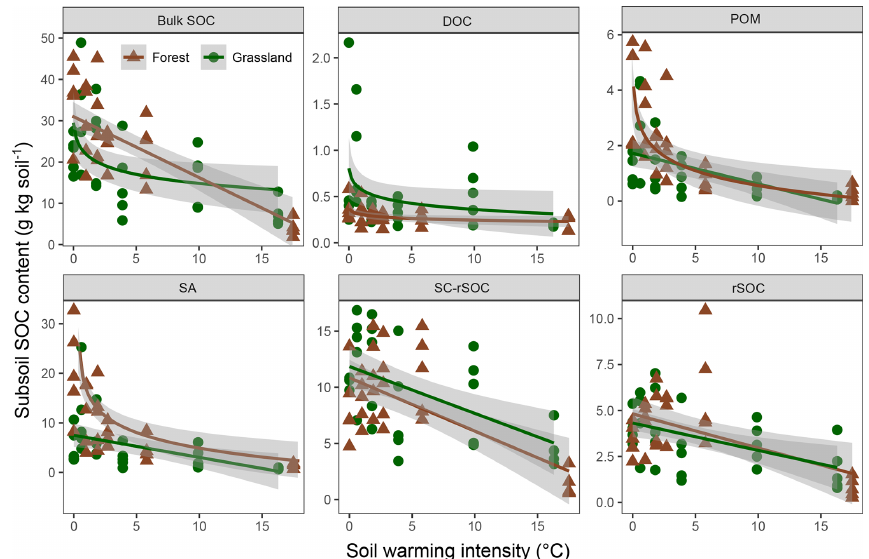
Figure 5. Scatter plots showing the soil organic carbon (SOC) content in the bulk soil and fractions of the forest and grassland subsoils (20–30cm) as a function of warming intensity with linear and logarithmic fits and the 95% confidence intervals. Fractions were dissolved organic carbon (DOC), particulate organic matter (POM), SOC in sand and aggregates (SA), non-oxidation-resistant silt- and clay-sized SOC (SC-rSOC), and oxidation-resistant silt- and clay-sized SOC